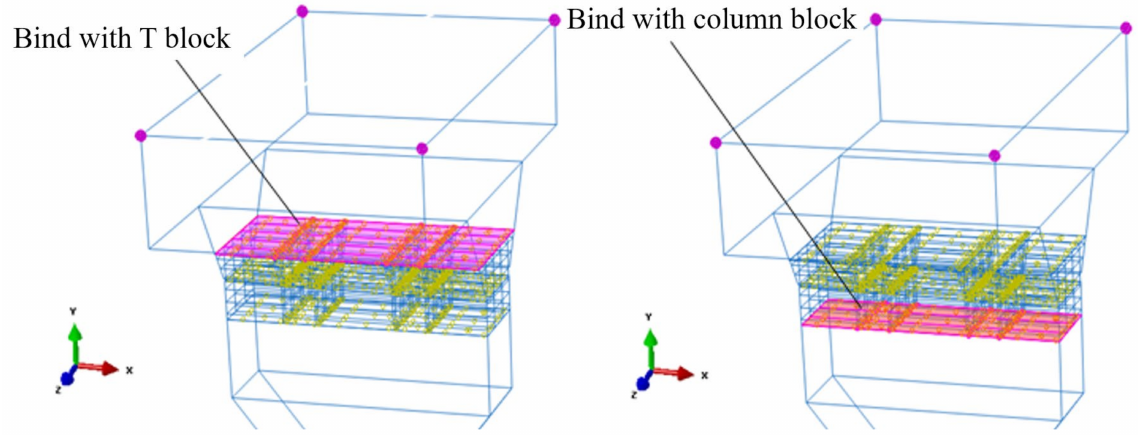
Figure 11. Connection of parts under different mesh densities.